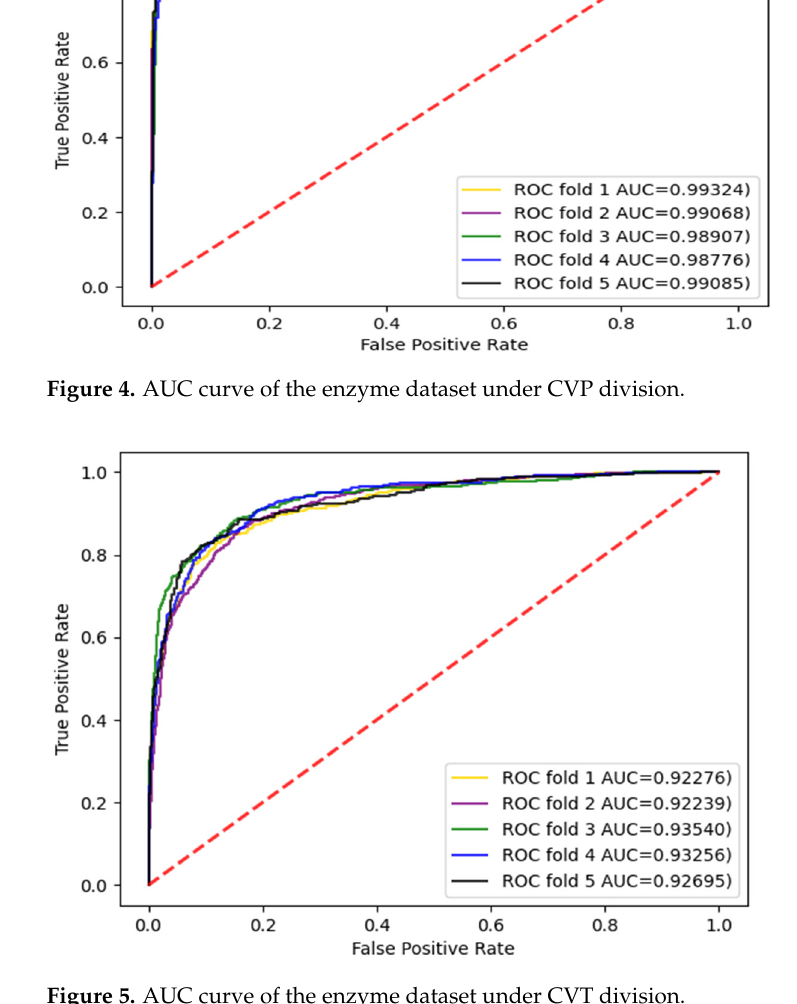
Figure 5. AUC curve of the enzyme dataset under CVT division.